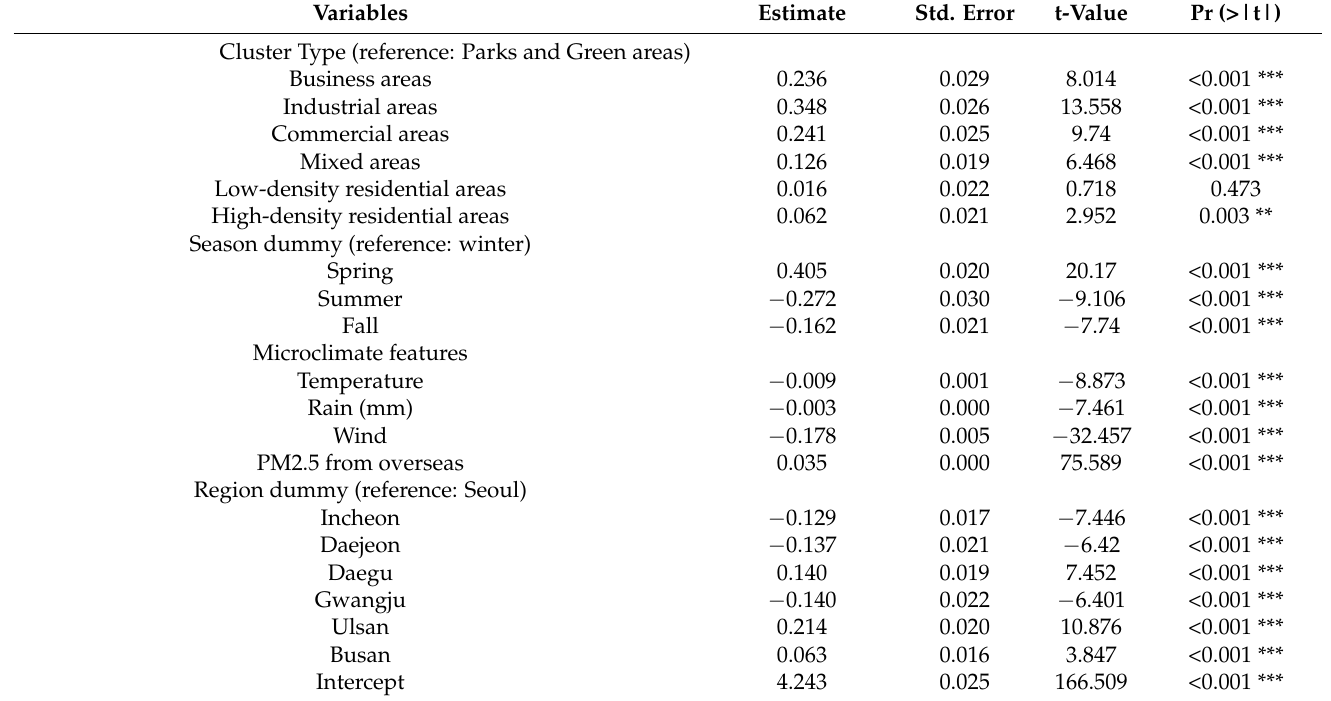
Table 7. Log-Lin Regression Model on Variability of Daily PM10 Concentration.